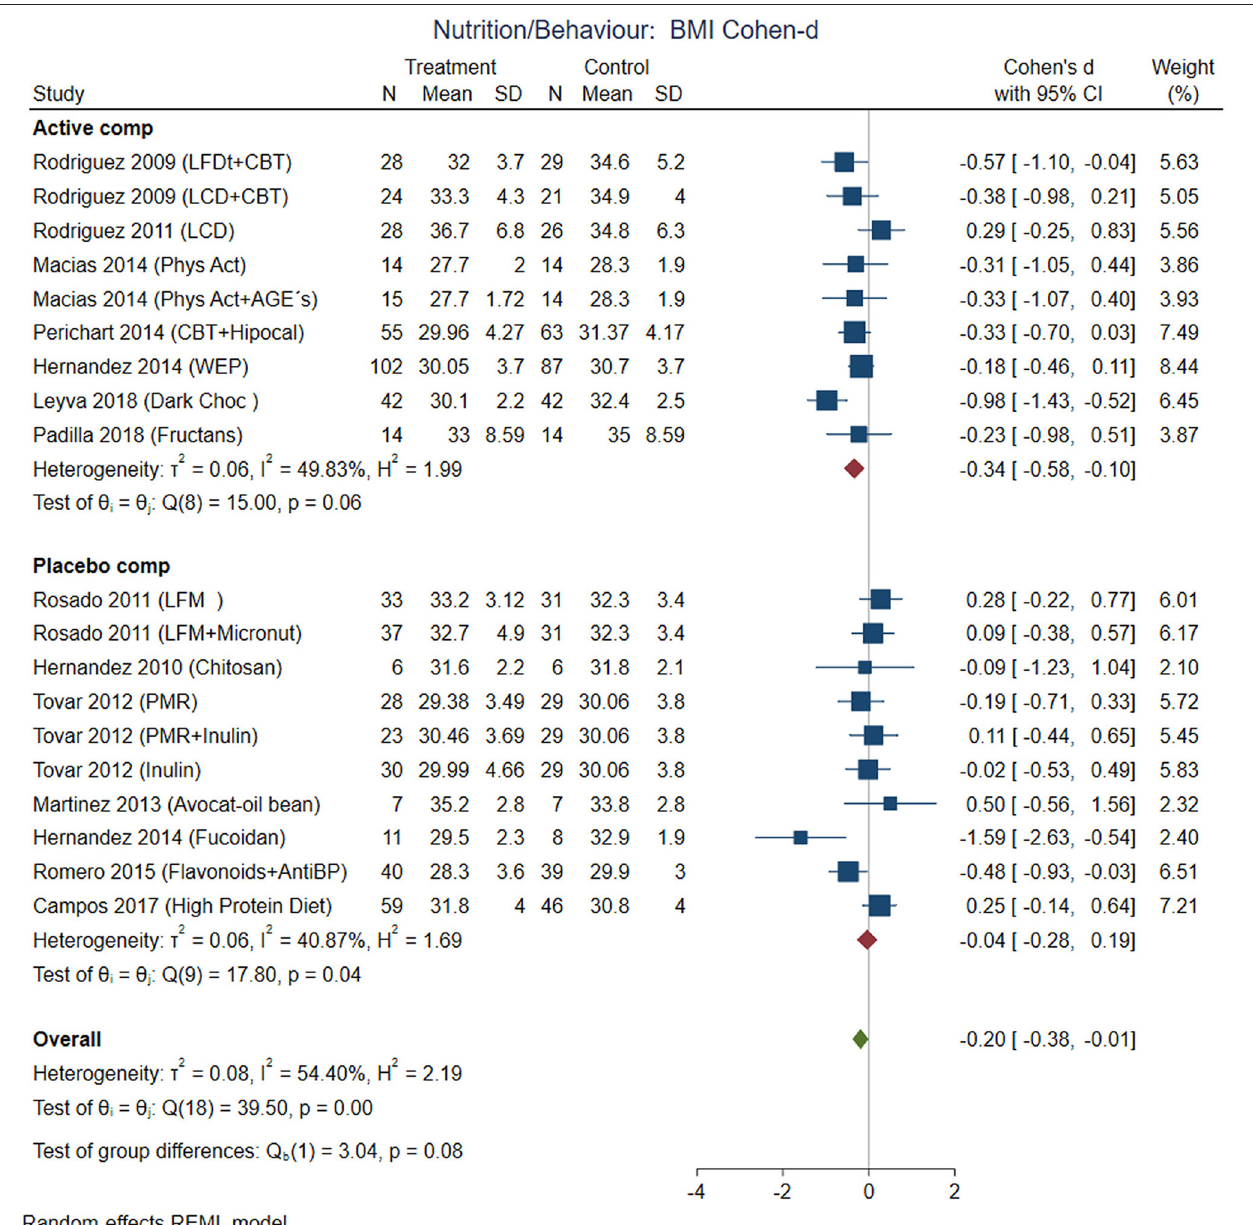
FIGURE 3 | Pooled analysis of Cohen’s d-weighted effect size on BMI reduction with nutritional and behavioral interventions. The analysis was stratified by placebo or active comparator. LFDT, Low fat diet; LCD, Low carbohydrate diet; CBT, Cognitive-behavioral therapy; Phys Act, Physical activity; Dark Choc, Dark chocolate; AGE, Advanced glycation end-product; Hipocal, Hypocaloric diet; WEP, Water and Education Provision; LFM, Low fat milk; Micronut, Micronutrients; PMR, Partial meal replacement; AntiBP, Antihypertensive medication; REML, Restricted maximum likelihood.